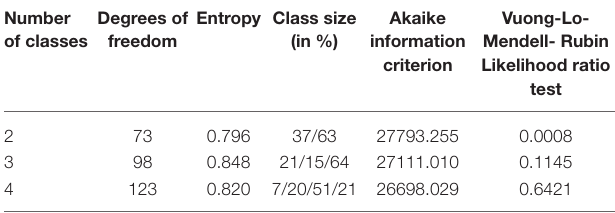
TABLE 6 | Fit indices of the three LCA